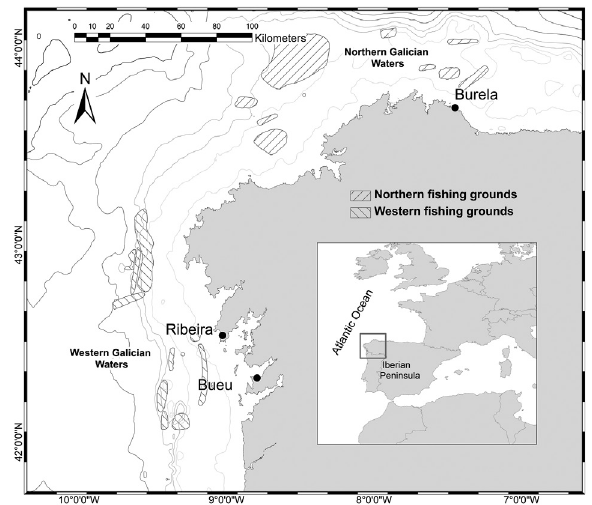
Fig. 1. – Location of the fishing ports where the Eledone cirrhosa specimens were between March 2009 and March 2010. Trawling fishing grounds catalogued in each zone are